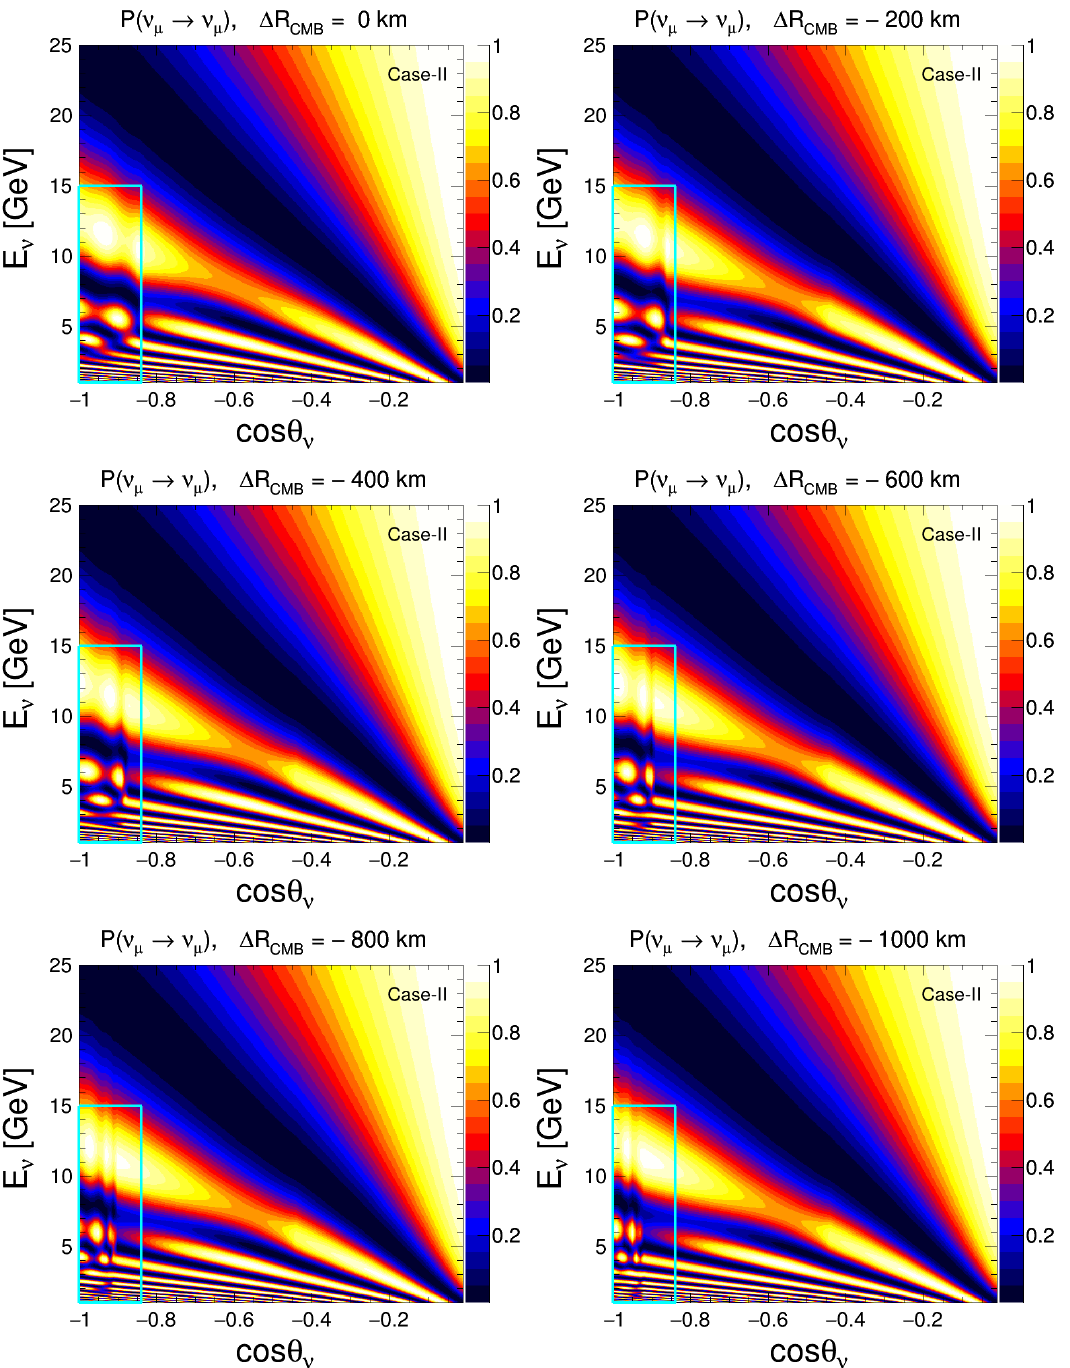
Figure 9 . Possible impact of smaller core radii on three-flavor ν µ → ν µ oscillograms for the three-layered profile of Earth. The oscillograms are shown for R ∆ R = (0 , − 200 , − 400 , − 600 , − 800 , − 1000) km, with the density profile modified according to CMB Case-II. We use three-flavor neutrino oscillation parameters given in table 2, where we assume NO and sin 2 θ = 23